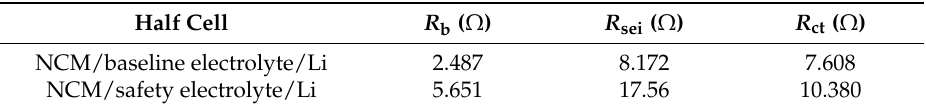
Table 2. Resistance parameters of R b , R sei and R ct obtained from simulation data.